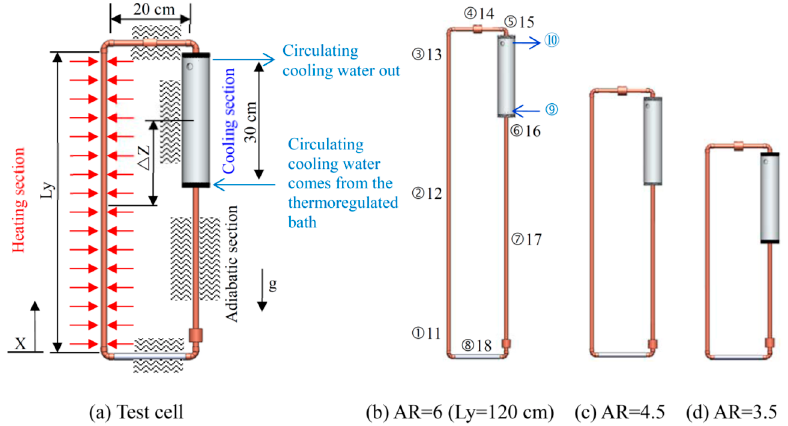
Figure 2. Experimental test cell and geometric parameters .